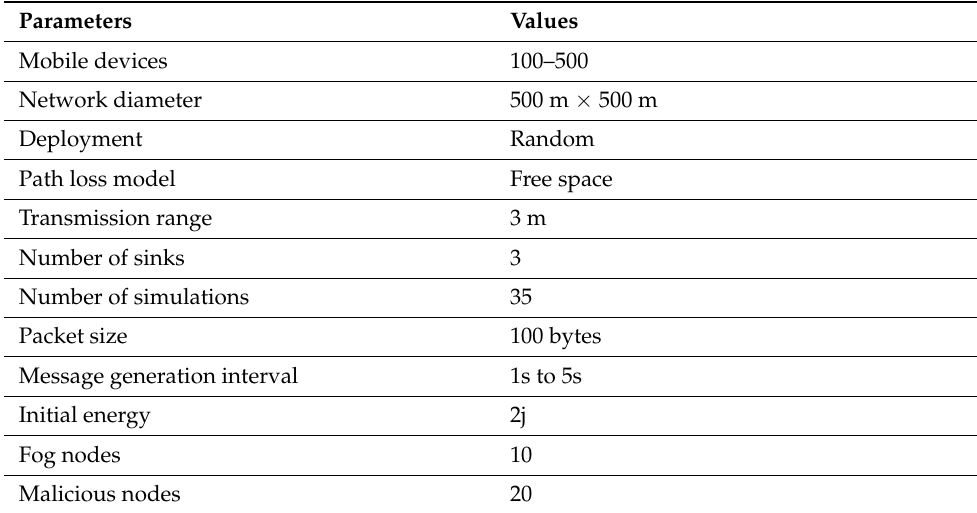
Table 2. Simulation